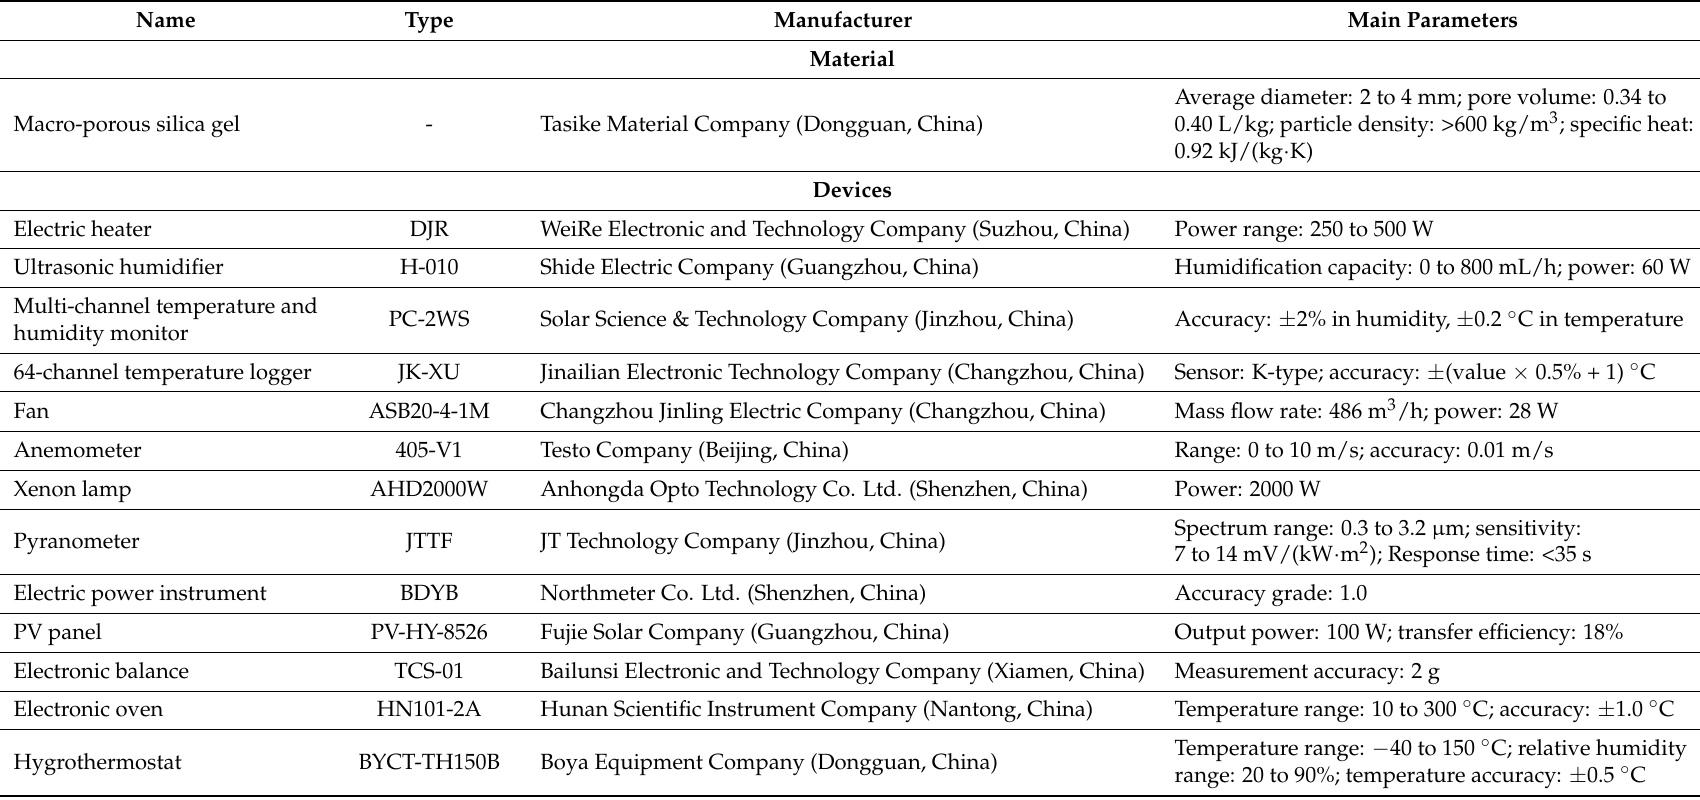
Table 1. The parameters of the main components of the solar-powered dehumidification window